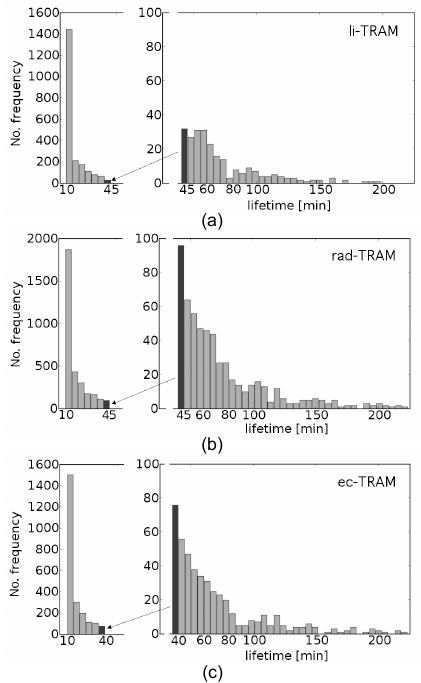
Fig. 6. Cell lifetime frequency distribution of completely assessed cell tracks for (a) lightning cells recorded by li-TRAM, (b) radar cells recorded by rad-TRAM, and (c) cells recorded by ec-TRAM. The number of solitude cell entries is for li-TRAM 6080, rad- TRAM 4565, and ec-TRAM 3480. In all three distributions the number of cells with lifetimes up to 55min is shown on separate